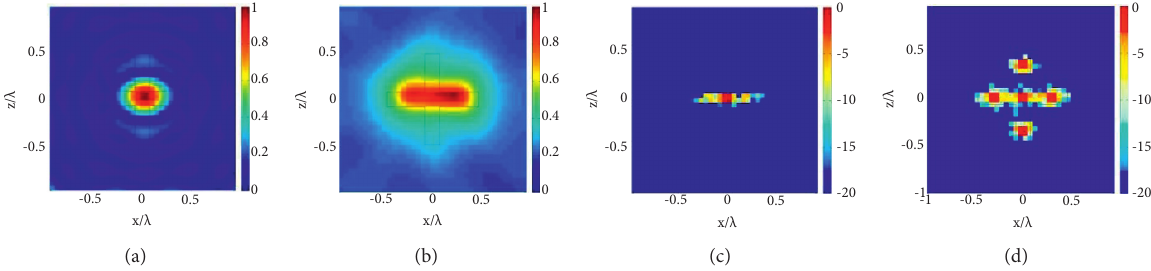
Figure 10: Reconstruction of the cross-shaped object a � 0.46 λ in xOy plane and φ -oriented dipoles. (a) TSVD, (b) LSM, (c) SSP, and (d) SHSP. SNR � 10 dB.